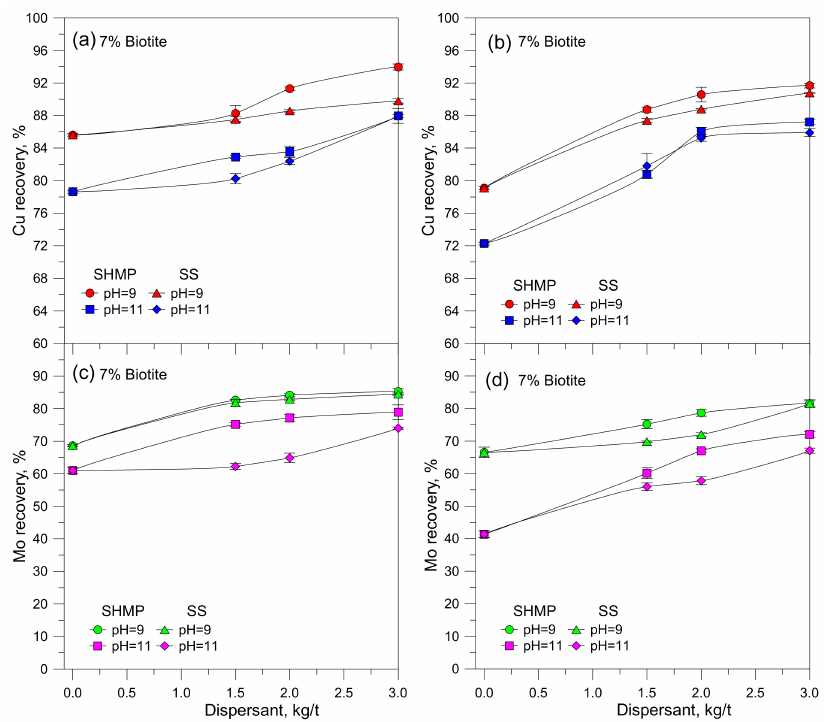
Figure 4. Copper ( a , b ) and molybdenum ( c , d ) recoveries and concentrate grades in seawater at pH 9 and 11, as a function of dispersant dosages (SHMP, SS), and two biotite